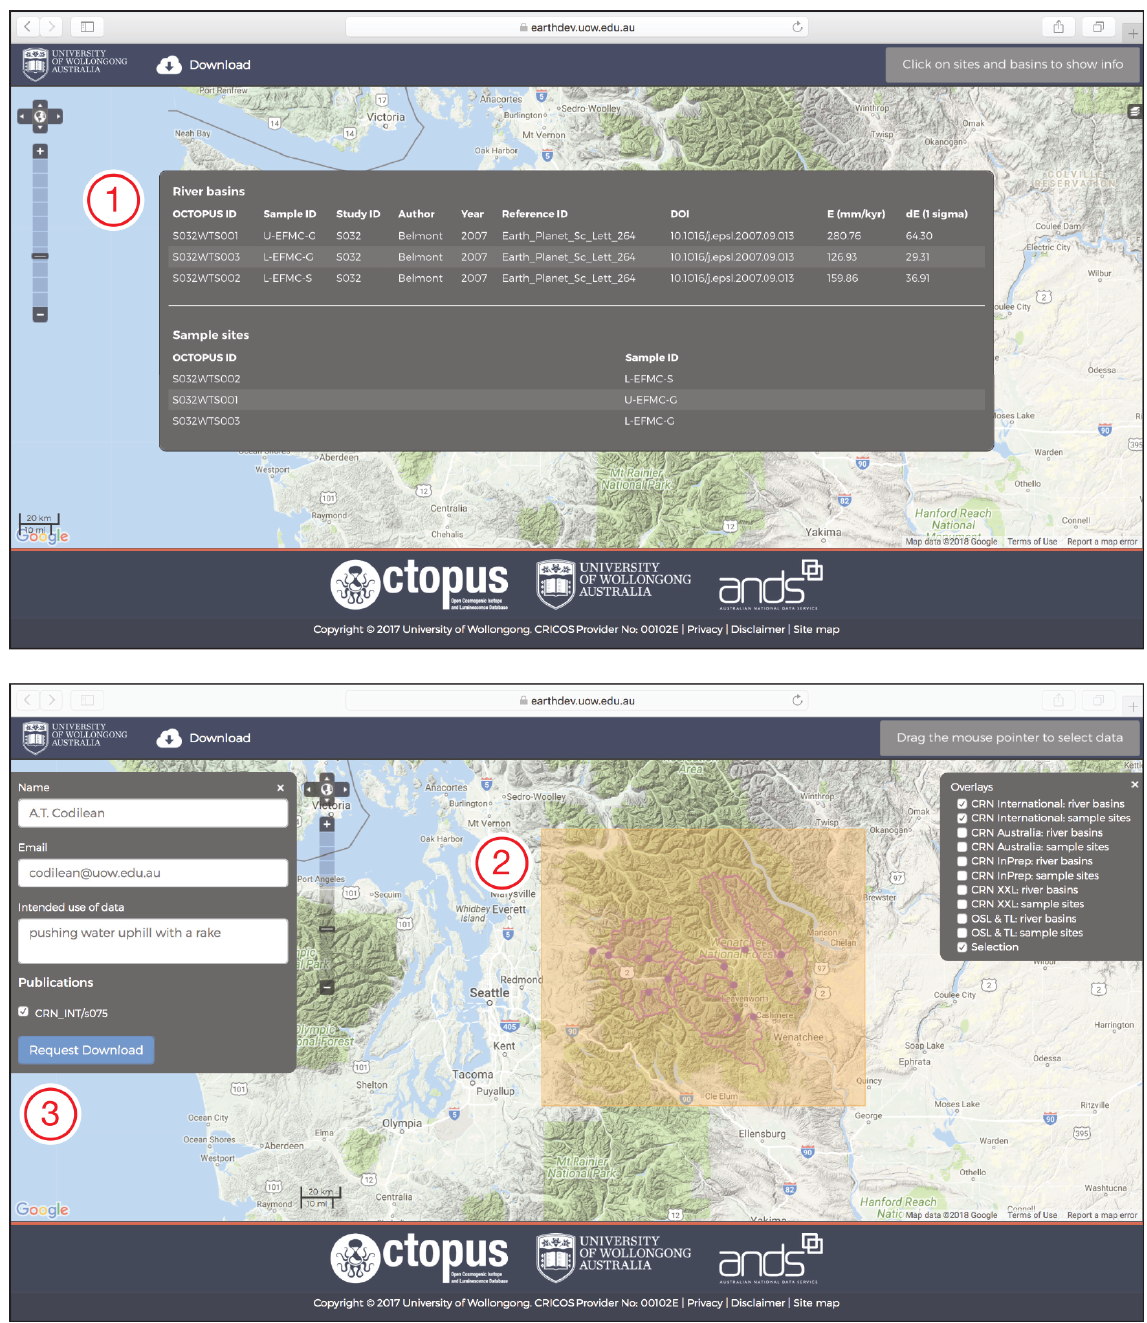
Figure 3. Screenshots of the OCTOPUS web page illustrating a typical user session. See text for more